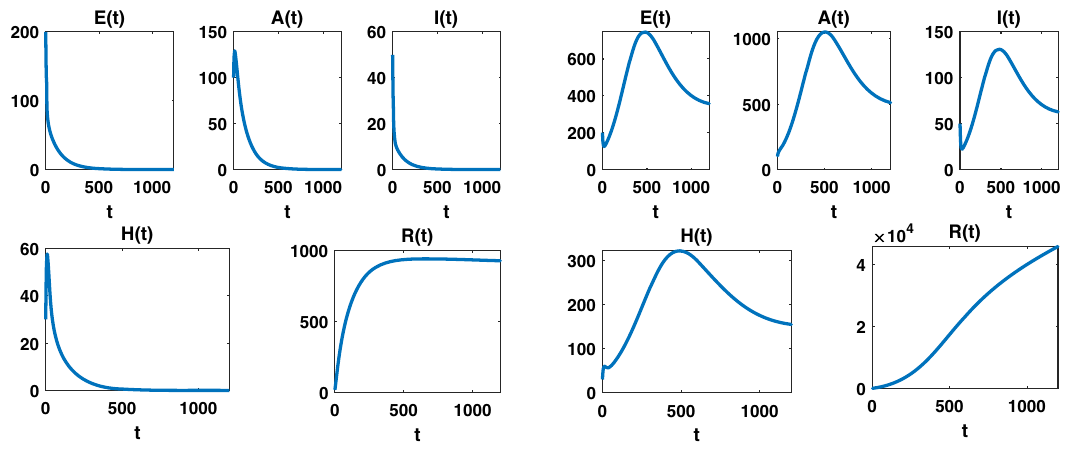
Figure 2: ( Left ) The plot of the population compartments as functions of time when = (cid:3) 0.7203 0 . ( Right ) The plot of the population compartments as functions of time when = (cid:3) 1.4406 0